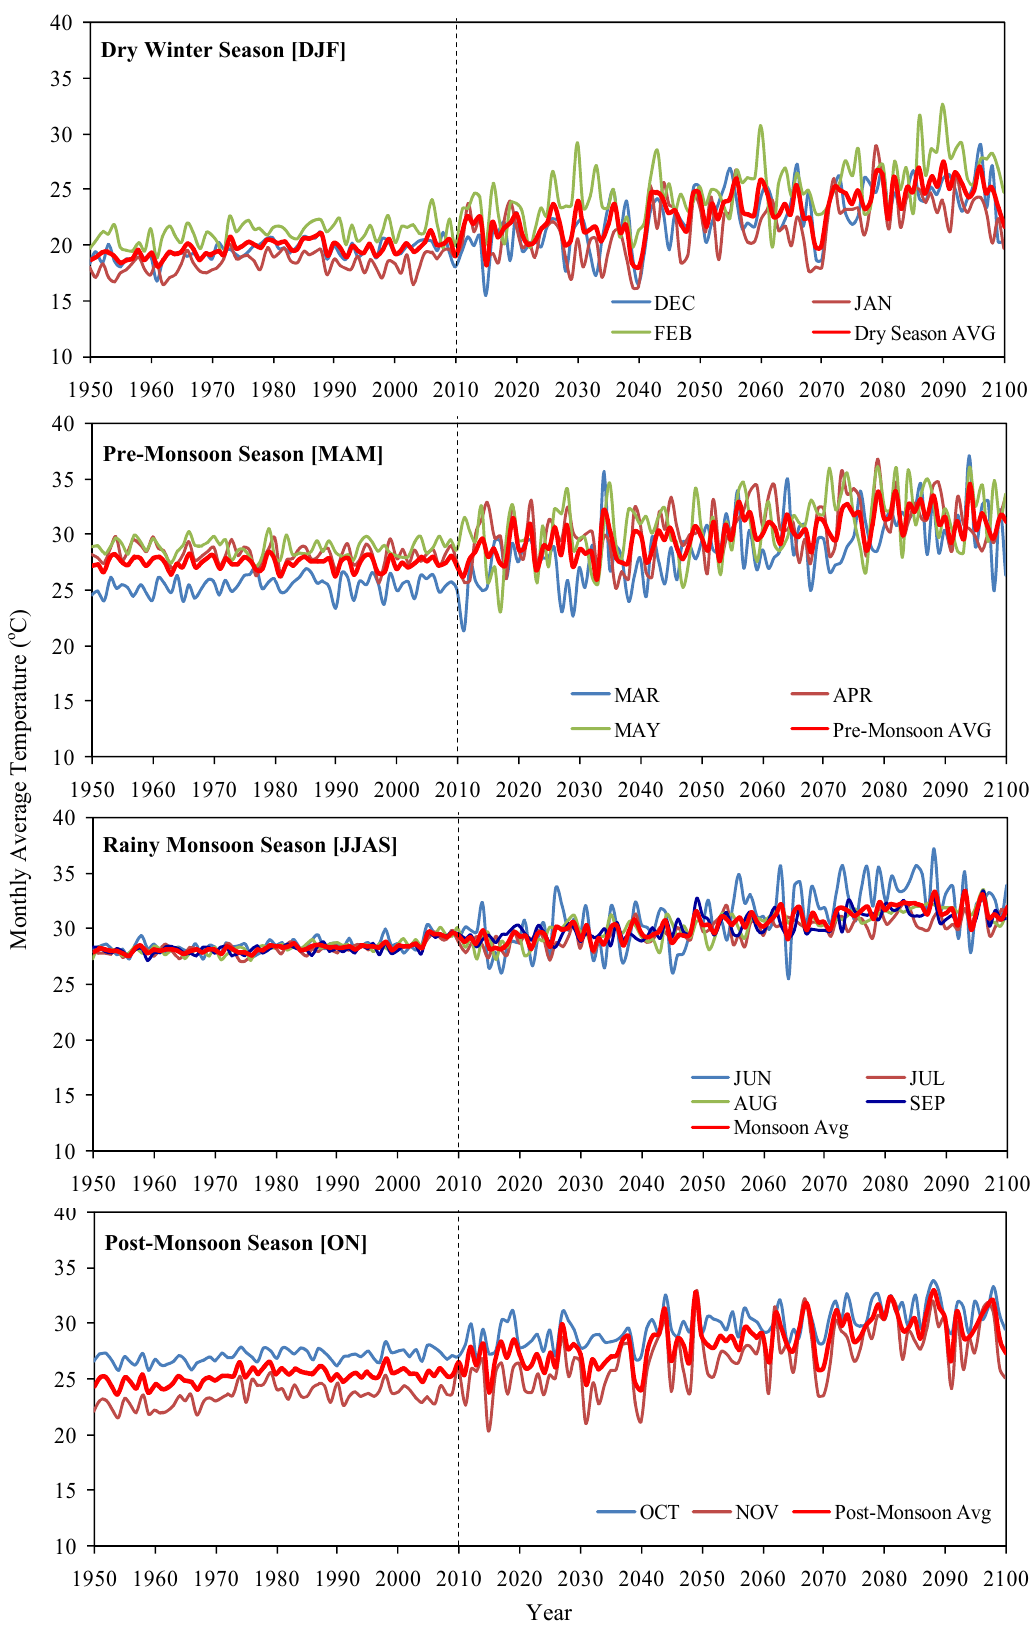
Figure 4. PRECIS projections of average monthly temperatures for Bangladesh up to the year 2100 with observed data of